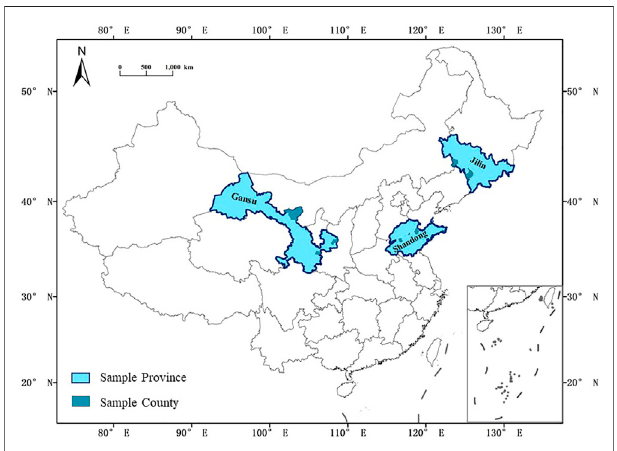
FIGURE 1 | Distribution of the study area in